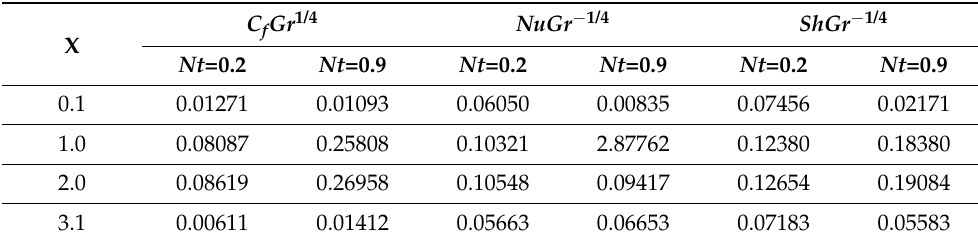
Table 4. Outcomes of the thermophoresis parameter N t on (a) the skin friction coefficient C f Gr 1/4 , (b) Nusselt NuGr − 1/4 , and (c) the Sherwood number ShGr − 1/4 when Sc = 10.0, Nb = 0.3, N = 1.0, and Pr = 7.0.